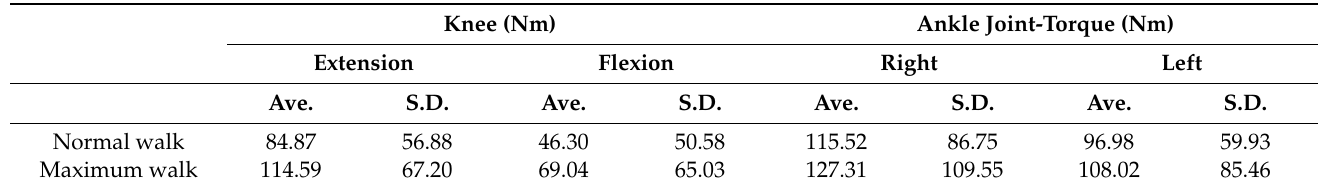
Table 6. Comparison of muscle factor during the normal walking and fast walking of the elderly.